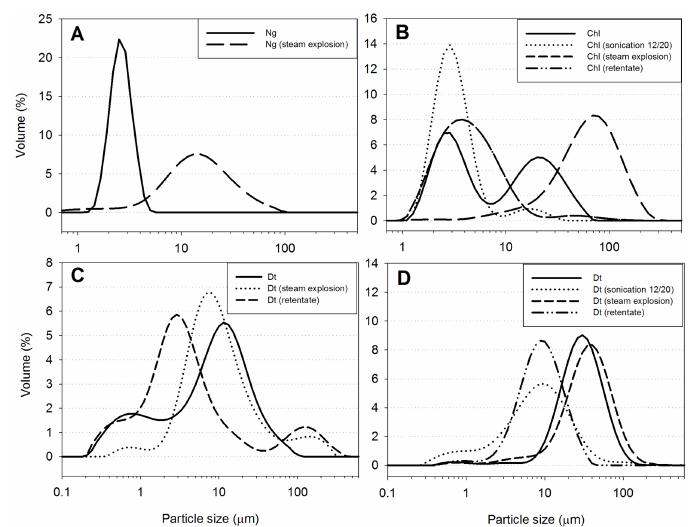
Figure 2. Particle size distribution results. ( A ) Nannochloropsis gaditana ( B ) Chlorella sorokiniana ( C ) Dunaliella tertiolecta (steam explosion with acid) ( D ) D. tertiolecta (steam explosion without acid). In all cases except those indicated, sonication was 0/12. All plots were obtained from an average of three measurements.